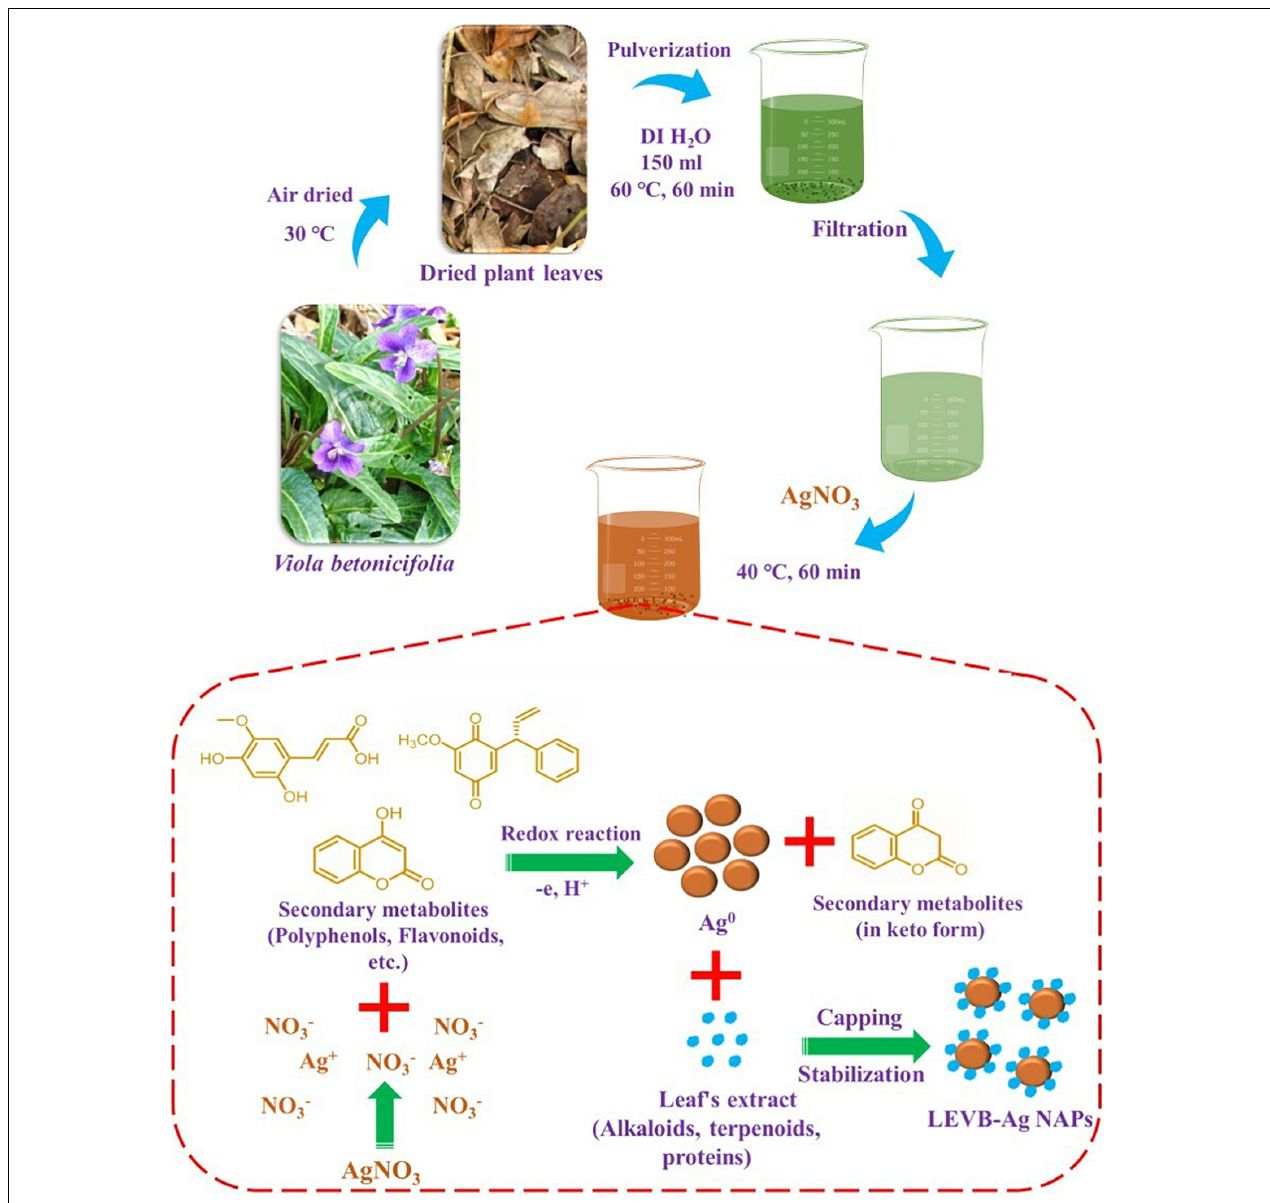
FIGURE 1 | Schematic presentation for the plant-mediated biosynthesis and synthesis mechanism of LEVB-Ag NAPs using the leaf extract of Viola betonicifolia .